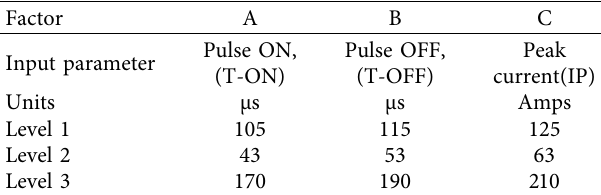
Table 5: Taylor Hobson.